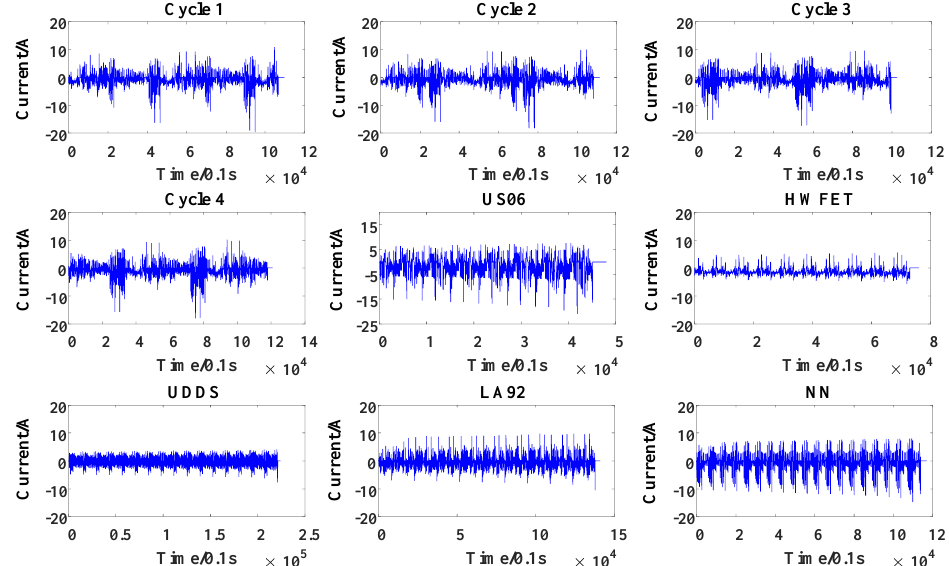
Figure 4. Current profiles measured in Cycle 1, Cycle 2, Cycle 3, Cycle 4, Supplemental Federal Test Procedure Driving Schedule (US06), the Highway Fuel Economy Test (HWFET), the Urban Dynamometer Driving Schedule (UDDS), the Los Angeles 92 (LA92), and Neural Network (NN).